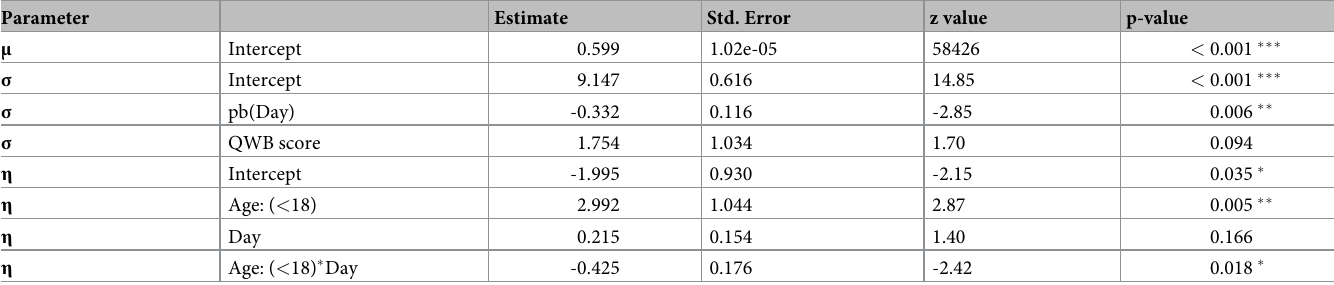
Table 5. Fixed effects of a GAMLSS predicting proportion of time spent at